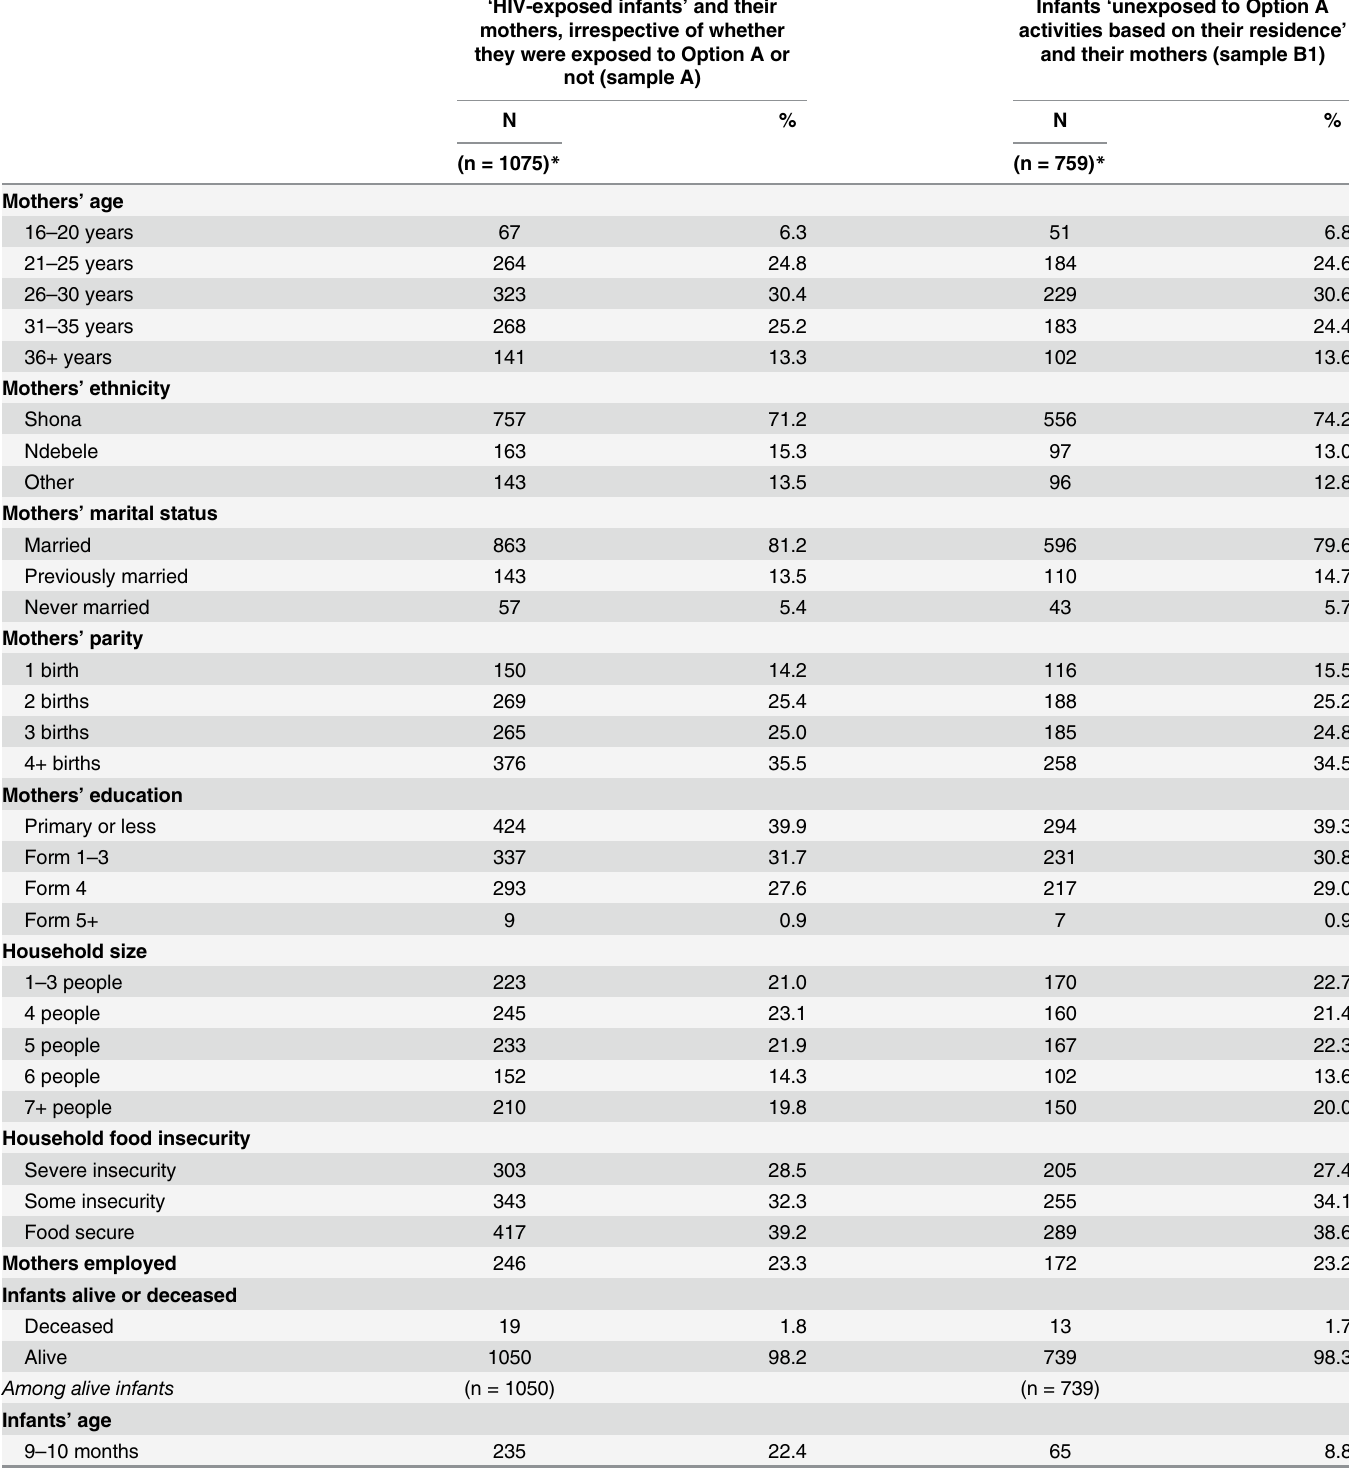
Table 2. Socio-demographic characteristics of mother-infant pairs enrolled in the baseline survey, for specific subpopulations (unweighted N and %), Zimbabwe, 2012. ‘ HIV-exposed infants ’ and